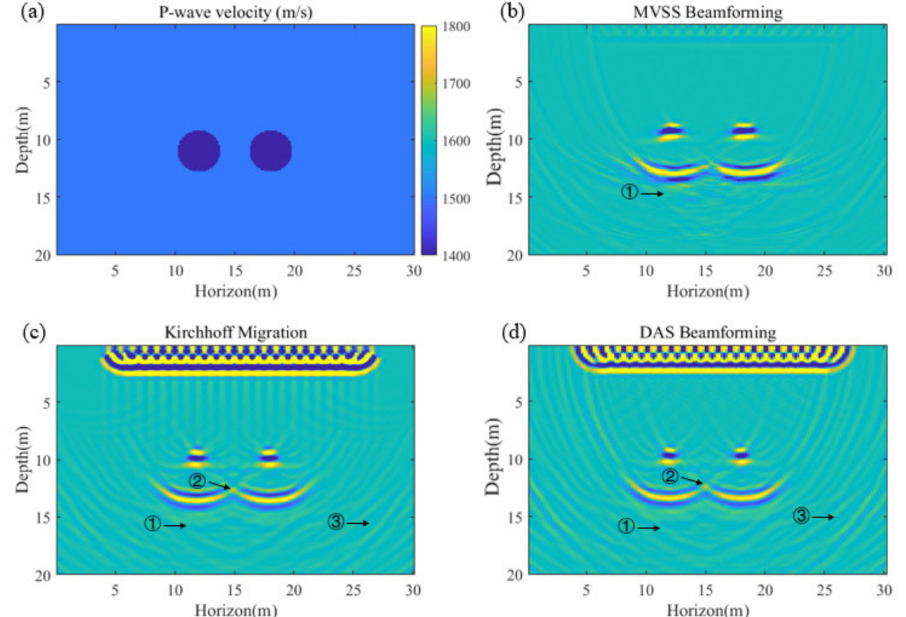
Figure 11. Model A-2. ( a ) True velocity model. ( b ) Imaging result of MVSS beamforming. ( c ) Imaging result of Kirchhoff migration. ( d ) Imaging result of DAS